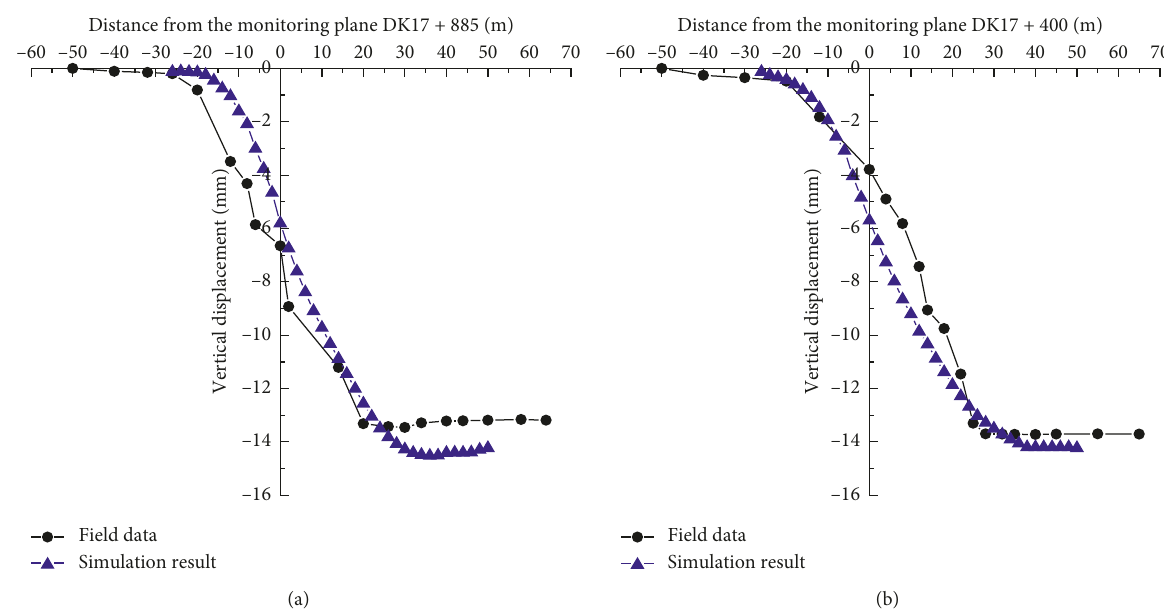
Figure 17: Longitudinal settlement comparison between simulation results and field data: (a) DK17 +885; (b) DK17